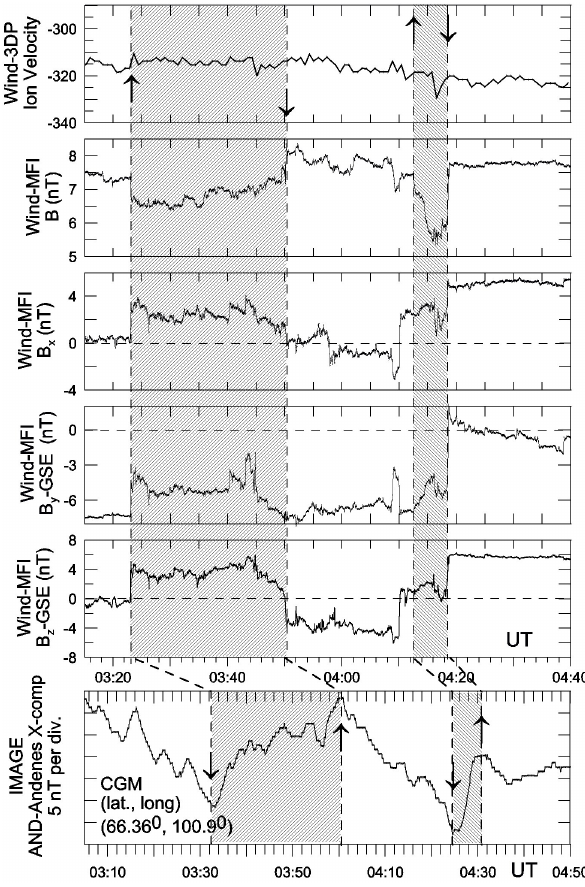
Fig. 5. The Wind spacecraft vector magnetic field measurements (MFI experiment) along with the ion plasma velocity (3DP instru- ment) and the ground Andenes (AND) station X-component trace (IMAGE array) throughout the interval of two successive solar wind pressure pulses (shaded areas) observed on 3 July 1997. The pulses do not change the pre-existing velocity